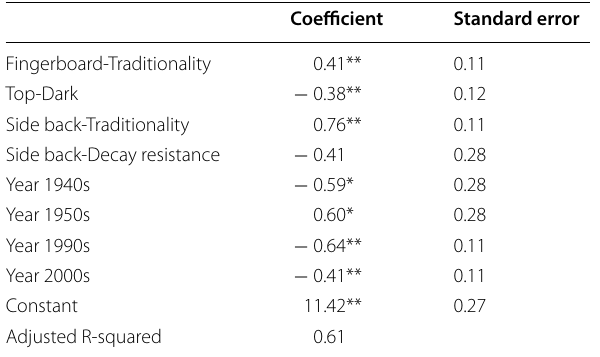
Table 5 Multiple regression analysis results for Martin guitars